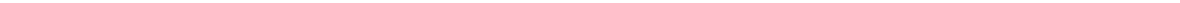
Fig. 2 TACI activates mTORC1 signaling by recruiting mTOR. a FCM of TACI and BCMA on human splenic FO and MZ B cells. Cells were gated as in Supplementary Fig. 11a b . Heat map showing enrichment or depletion of coordinated gene sets identi fi ed by GSEA in the transcriptome from human MZ B cells cultured for 3 h with or without APRIL and/or rapamycin (rapa). Ctrl medium. NES indicates correlation between individual gene sets. Positive correlation, NES > 0 (yellow gradient); negative correlation, NES < 0 (blue gradient). c GSEA of the mTORC1 gene signature identi fi ed in b and heat map listing top 25 genes similarly enriched or depleted under different treatment conditions. Colors correspond to signi fi cant FC expression: red, high; blue, low. Bold indicates genes discussed in the text. d IB of total or p(S2448)-mTOR, p(37/46)-4E-BP1, p(T389)-70S6K, and p(S235/236)-S6 in human splenic IgD + B cells incubated for 0, 5, 15, or 30 min with APRIL in the presence or absence of rapamycin. Red numbers indicate band intensity relative to total protein. e IB of total or p(S235/236)-S6 in human splenic IgD + B cells incubated for 15 min with APRIL in the presence or absence of Ly294002 or Torin 1. f Phospho-proteome analysis of p(S235/236)-S6, p(T308)-AKT, and p(S473)-AKT from human splenic MZ B cells stimulated with APRIL for 15 min. Graphs show mean pixel density of dot blots. OD optical density. g IB of mTOR, MyD88, TRAF2, IRAK-4, IRAK-1, and TACI following IP with anti-TACI or irrelevant IgG of protein lysates from splenic IgD + B cells incubated with or without APRIL and/or rapamycin for 15 min. Ctrl, medium alone. h FCM of WT and S194X TACI on lymphoblastoid B cells from a healthy donor (HD) or a common variable immunode fi ciency (CVID) patient, respectively. i IB of mTOR, MyD88, and TACI following IP with anti-TACI or irrelevant IgG antibodies of protein lysates from B cells shown in h stimulated as in g . Data summarize one representative experiment with at least three biological replicates for each cell type ( a – c , f , h ) or show one experiment of at least three with similar results ( d , e , g , i ). Error bars, s.e.m.; * p < 0.05 (two-tailed Student ’ s t